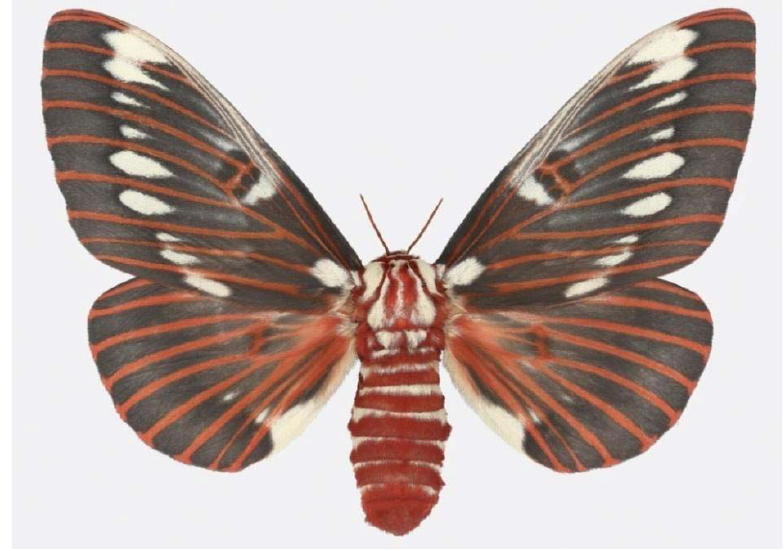
Figure 5. An Arizona beauty, the silk moth Citheronia splendens , a female.